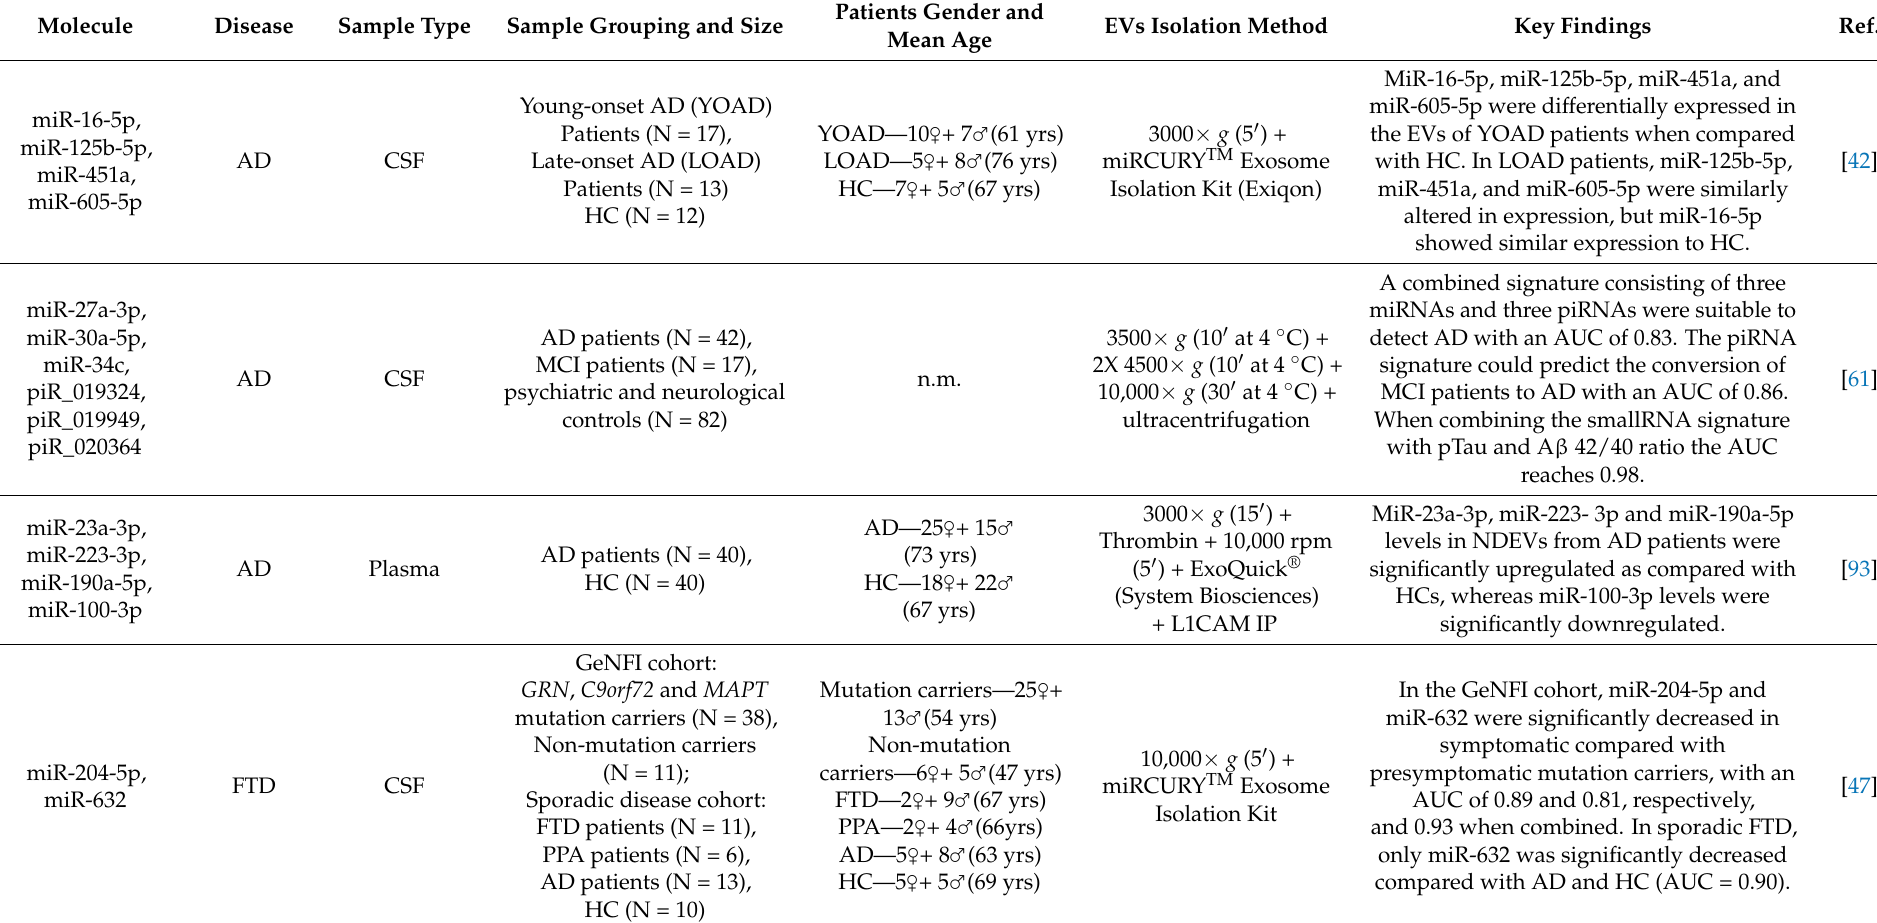
Table 2. Extracellular vesicles non-coding RNAs as biomarkers associated with central nervous system pathological